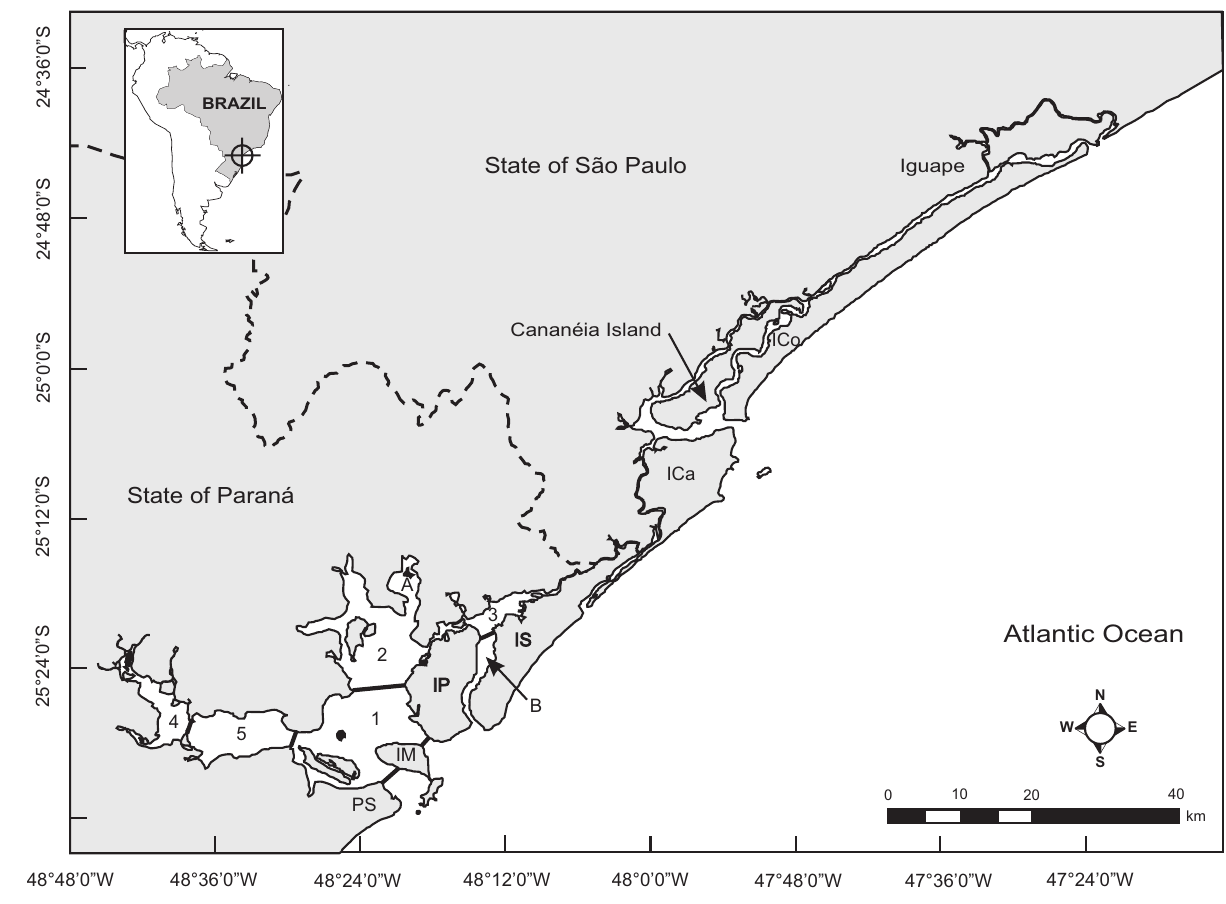
Figure 1. The Lagamar estuary, from Iguape, São Paulo State, to Pontal do Sul (PS), Paraná State, and the Paranaguá Estuarine Complex. Sectors: (1) Mixture Zone, (2) Laranjeiras, (3) Pinheiros, (4) Antonina, (5) Paranaguá; sub-estuaries: (A) Guaraqueçaba, (B) Canal do Superagui, (IM) Ilha do Mel, (IP) Ilha das Peças, (IS) Ilha do Superagui, (ICa) Ilha do Cardoso, (ICo) Ilha Comprida. Modified from N OERNBERG et al.